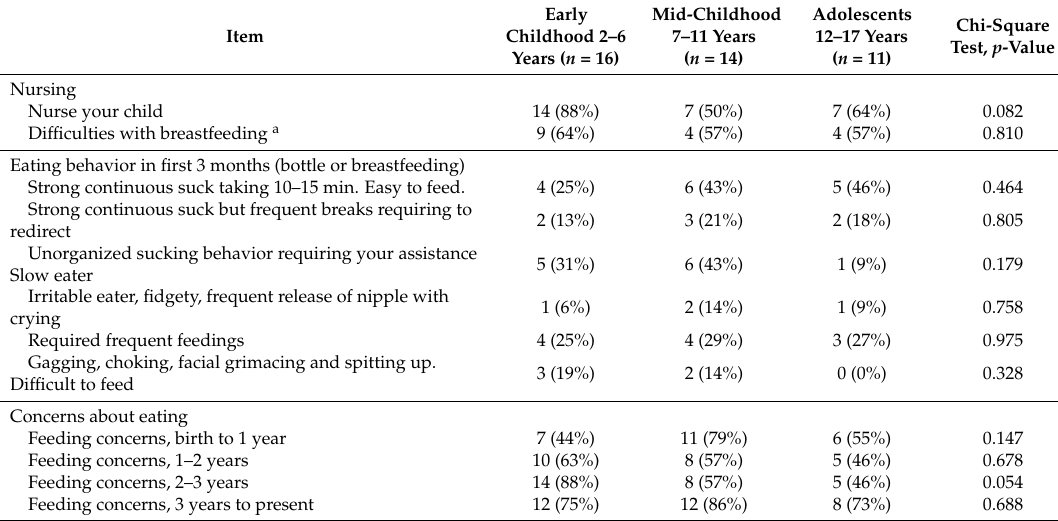
Table 2. Early history by age group.